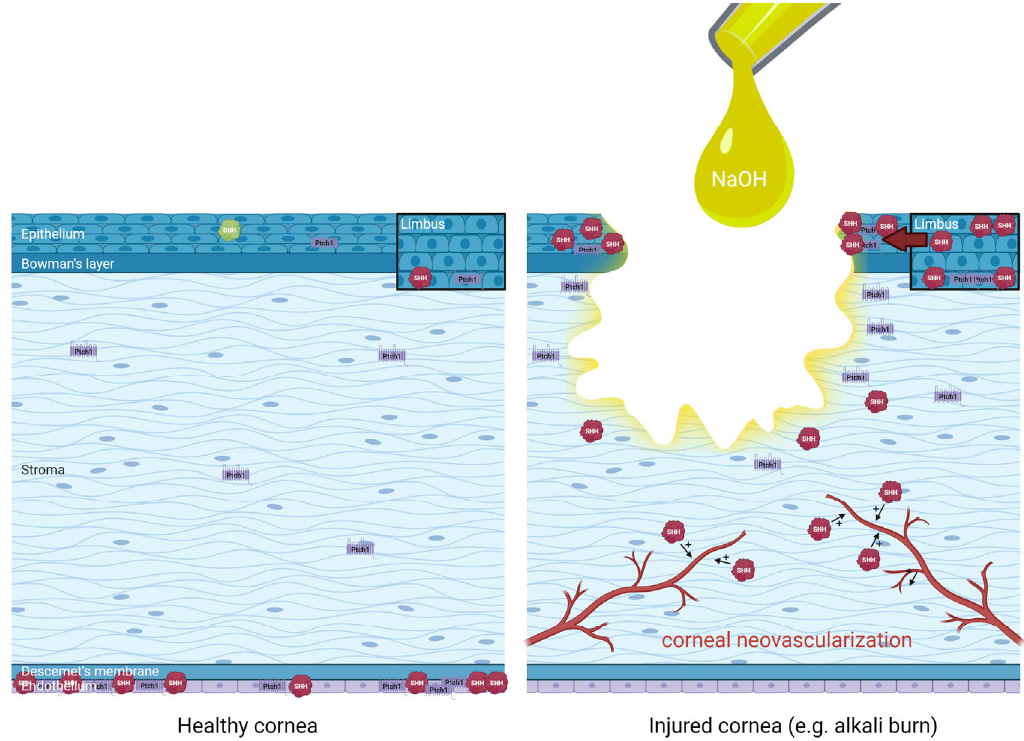
Figure 4. Distribution and regulation of Hedgehog pathway effectors in healthy human cornea (left panel) and injured cornea such as following an alkali burn with sodium hydroxide (NaOH) (right panel), extrapolating data from animal studies for didactic purposes. An upregulation of limbal Sonic Hedgehog (SHH) in basal epithelial cells and superficial epithelial cells have been evidenced, in association with increased Hedgehog pathway effectors such as Patched ‐ 1 (Ptch1) around the wound edges and increased SHH in the migrating epithelium during corneal wound healing. Finally, the role of SHH in the promotion of pathological corneal neovascularization is also illustrated. Distribution based on data from Saika et al. 2004 [50], Fujita et al. 2008 [55], Fujita et al. 2009 [51], Kucerova et al. 2012 [48], Hirata-Tominaga et al. 2013 [54], Fan et al. 2019 [52], Li et al. 2018 [53], Vincente et al. 2018